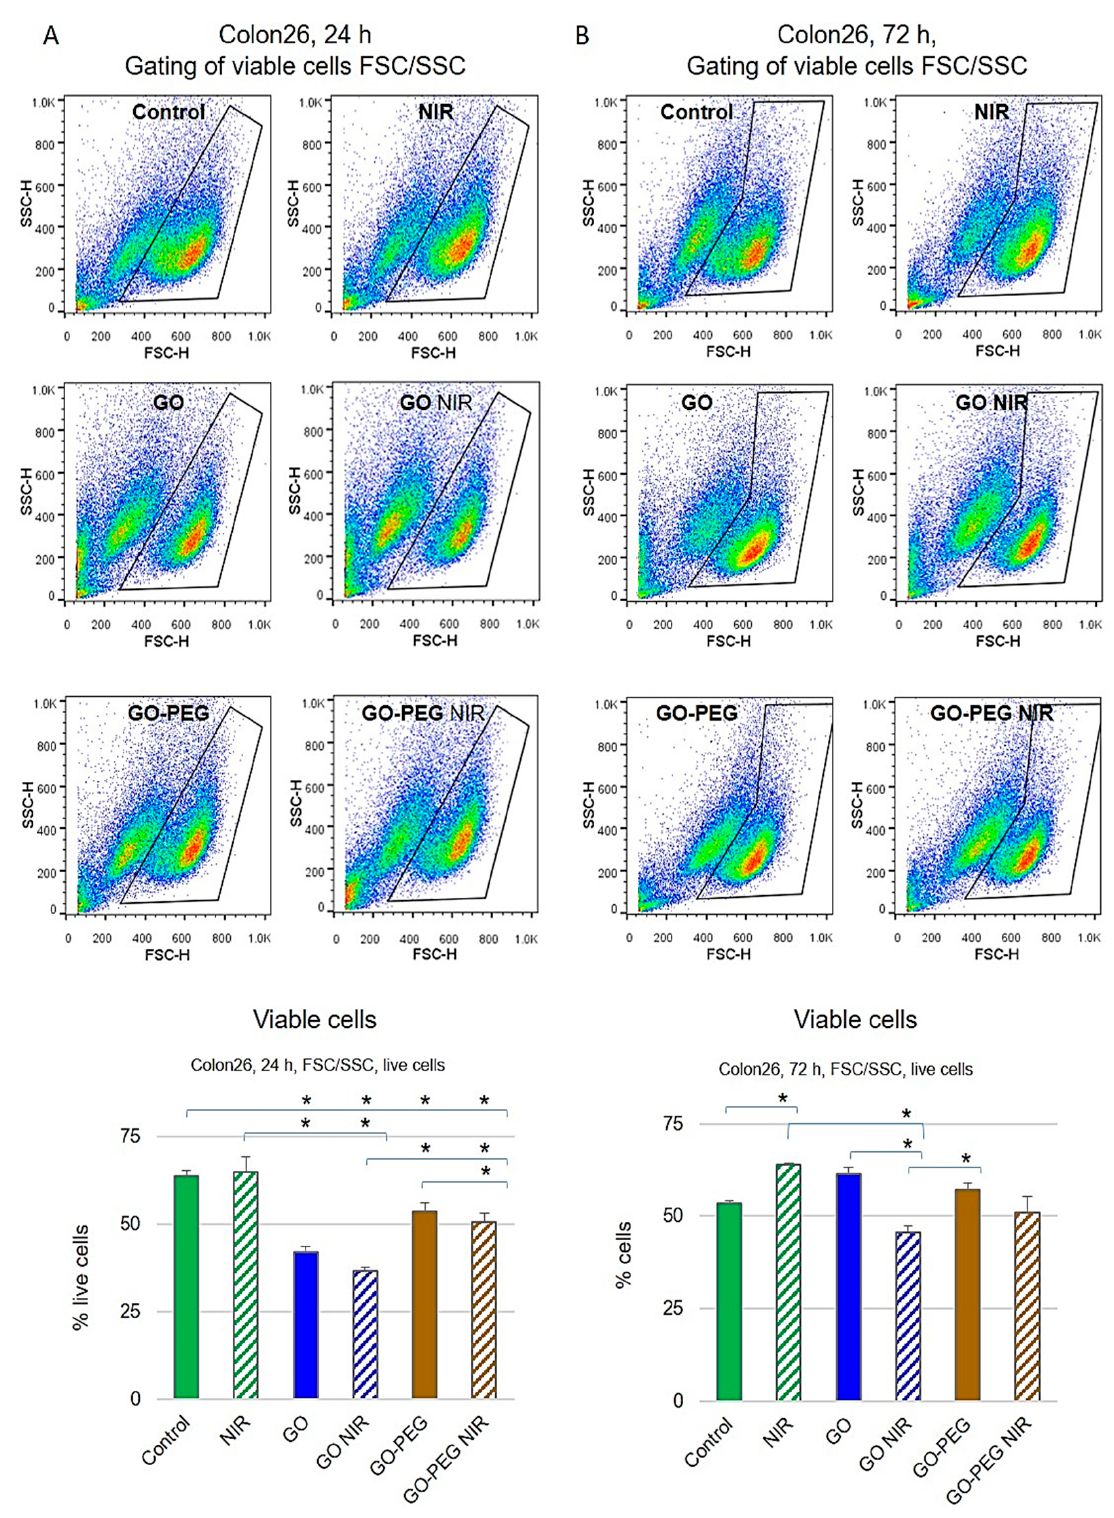
Figure 3. Cytotoxic effect of GO nanoparticles with or without NIR on Colon26 cells by FACS after staining of cells with Rh123. Representative dot-plots of FSC (forward side scattering) vs. SSC (side scattering) for Colon26 cells are presented. The population of viable cells was gated and the calculated percentage of live cells is given on the charts. ( A ) Colon26 viability after 24 h of cultivation with NPs. ( B ) Colon26 viability after 72 h of cultivation with NPs. Three repetitions of the experiment were carried out and results are the MEAN values of the calculated % of viable cells. Statistically significant differences are denoted with * p <